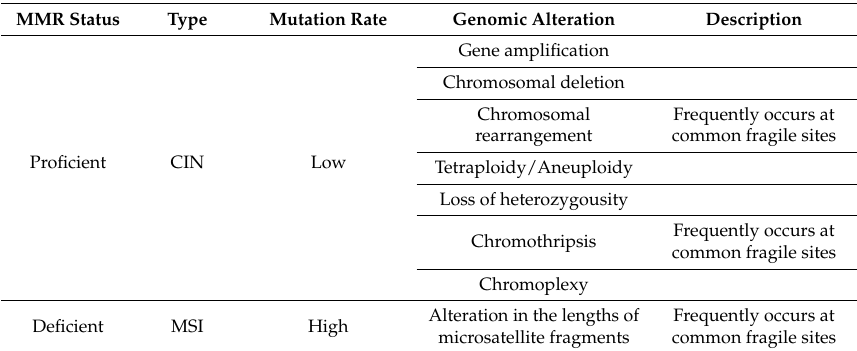
Table 1. Types of genomic instability induced in cancer